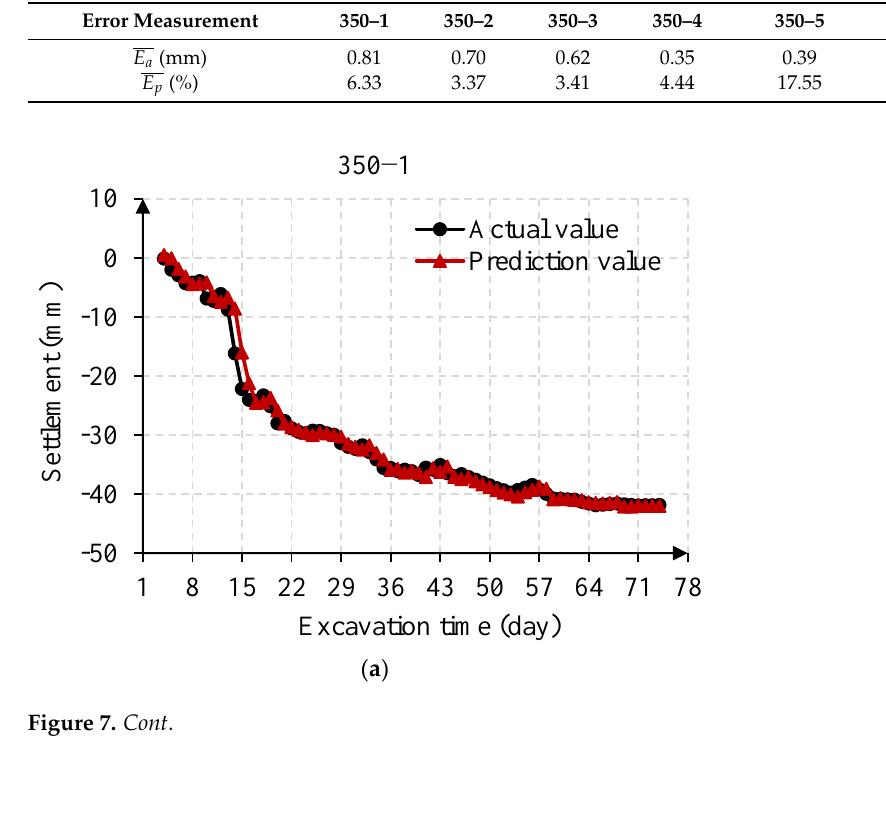
Table 2. Average prediction errors of the optimum BPNN.